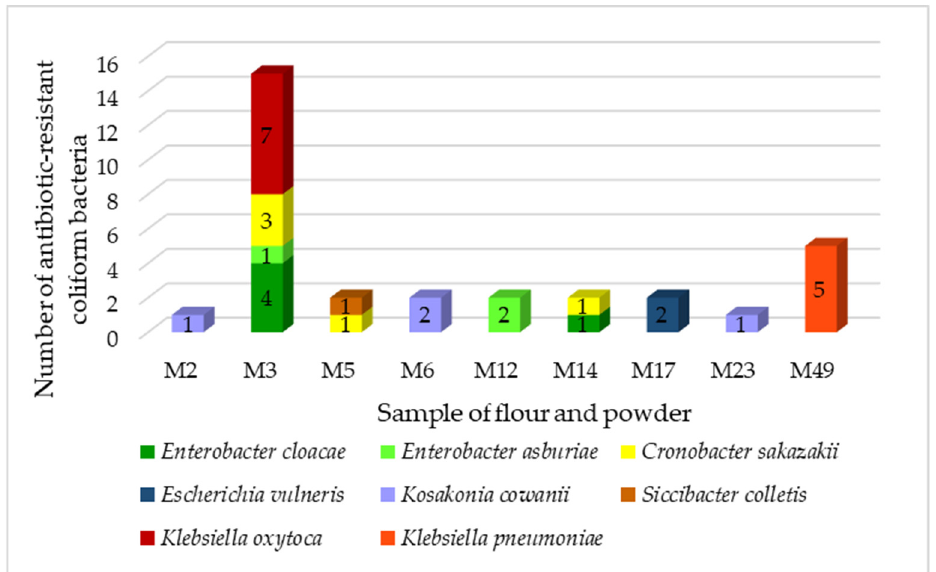
Figure 1. Antibiotic-resistant coliform bacteria isolated from flour, powder. M2—Teff, M3—Chestnut, M5—Amaranth, M6—Rice wholegrain, M12—Banana, M14—Chestnut, M17—Sorghum, M23—Rye, M49—Cricket.